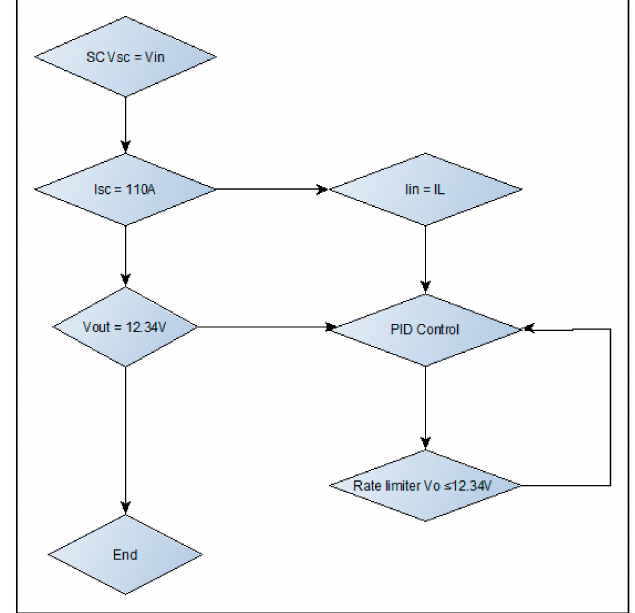
Figure 5. Control strategy of the buck-boost controller for the supercapacitor.